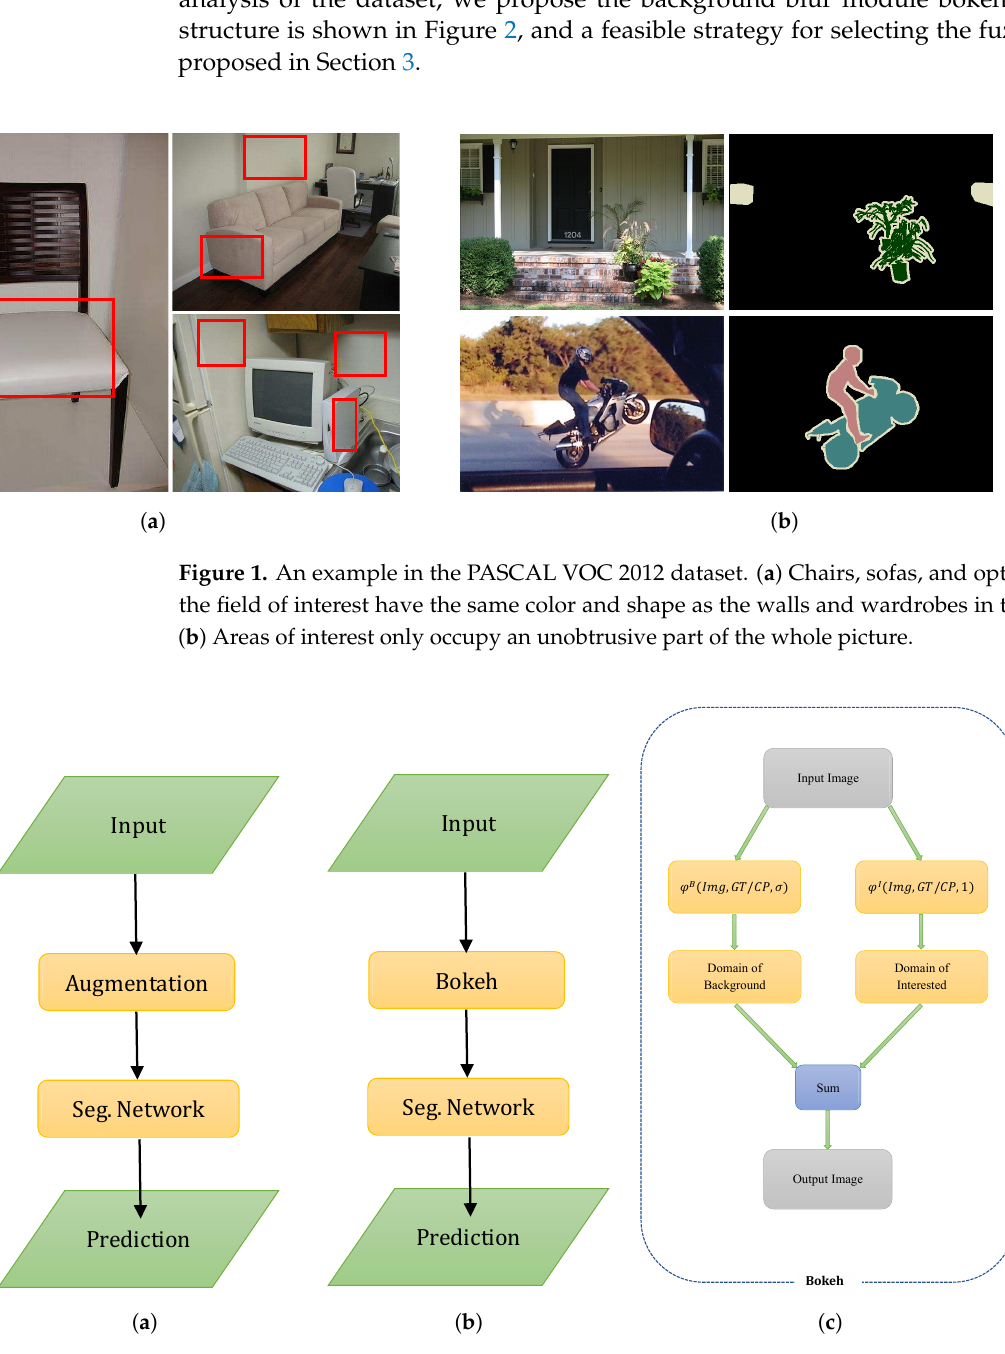
Figure 2. ( a ) Existingmainstream semantic segmentation network architecture. ( b ) The segmentation network architecture of this paper. ( c ) bokeh module, see Section 3 for algorithm